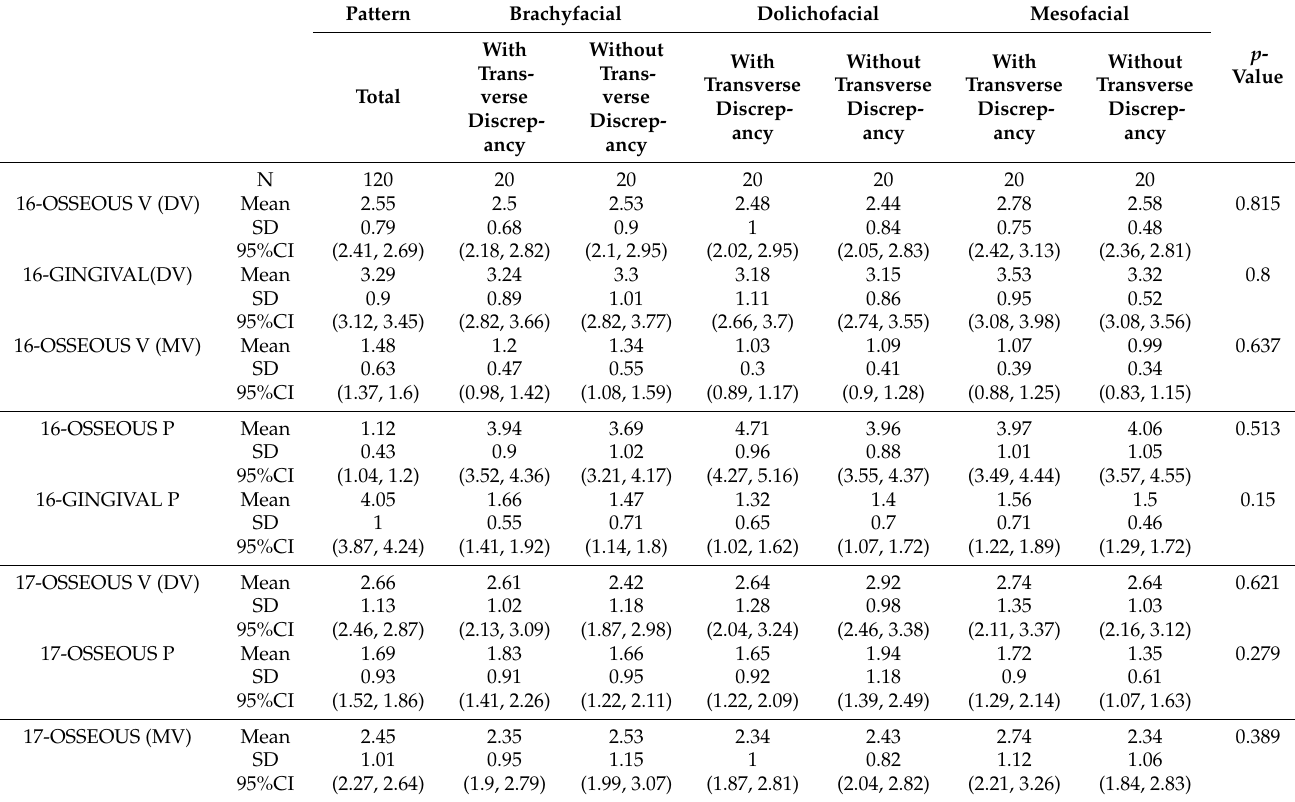
Table 6. Linear measurements corresponding to upper right molars in the different vertical facial patterns, in the presence and absence of transverse bone discrepancy. Pattern Brachyfacial Dolichofacial Mesofacial With Without p - With Without With Without Trans- Trans- Value Transverse Transverse Transverse Transverse Total verse verse Discrep- Discrep- Discrep- Discrep- Discrep- Discrep- ancy ancy ancy ancy ancy ancy